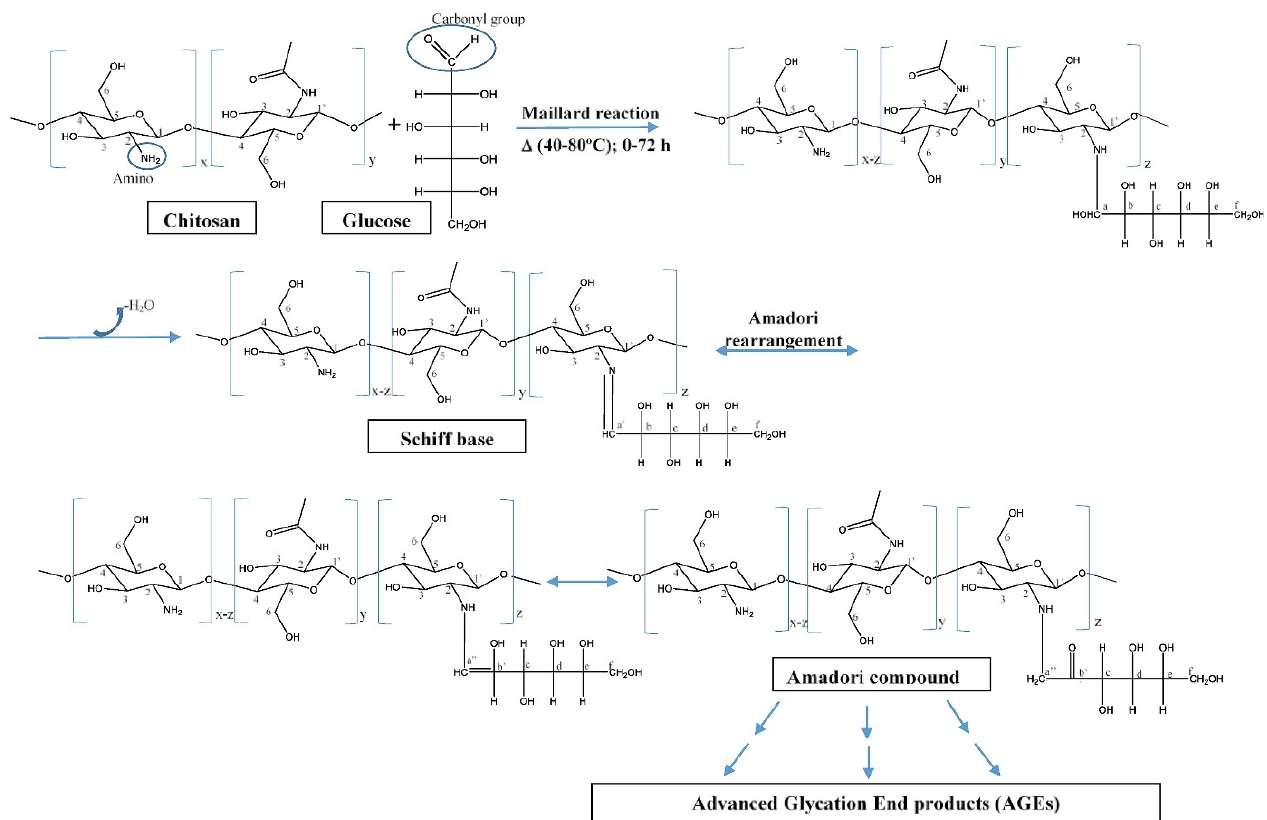
Figure 7. The reaction scheme for a CS derivative with sugar via the Maillard reaction [225]. Repro- duced with permission from Elsevier (Copyright©2016).